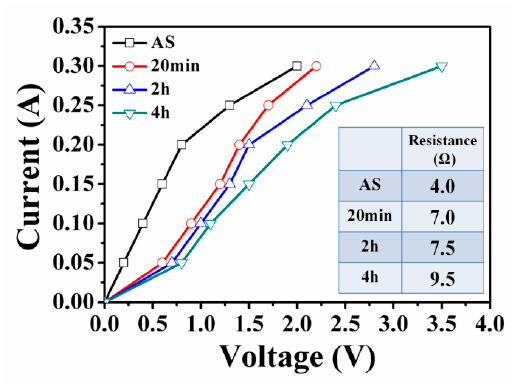
Figure 6. Electrical properties of the PCA ball bond wire after sulfidation.